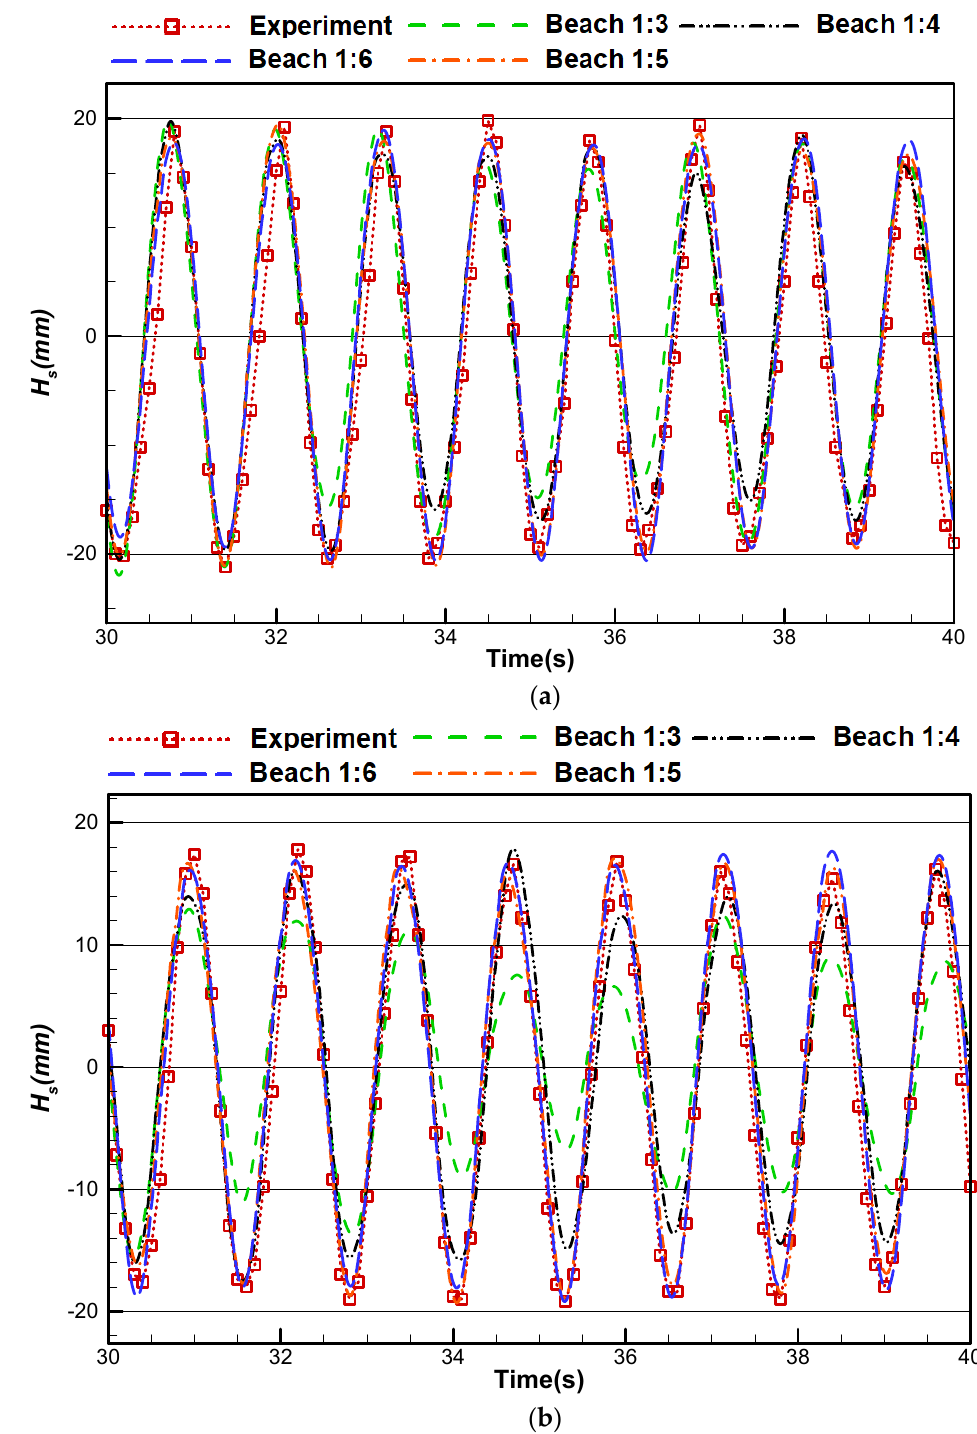
Figure 24. Wave height of case 5 for different beach slopes at a distance of ( a ) 3 m and ( b ) 5 m from the flap.